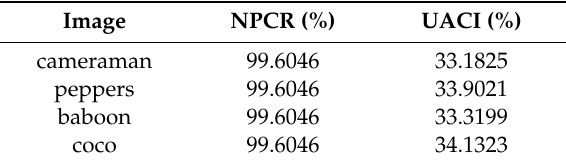
Table 3. The values of the number of pixel change rate (NPCR) and unified average changing intensity (UACI).